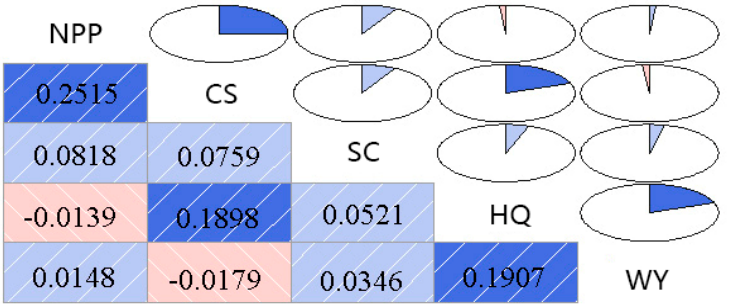
Figure 4. Corrgram of ES pairs in the Yellow River Basin (the values in the lower-left of each graph are the correlation coefficients of each ES pair in the whole Yellow River Basin).